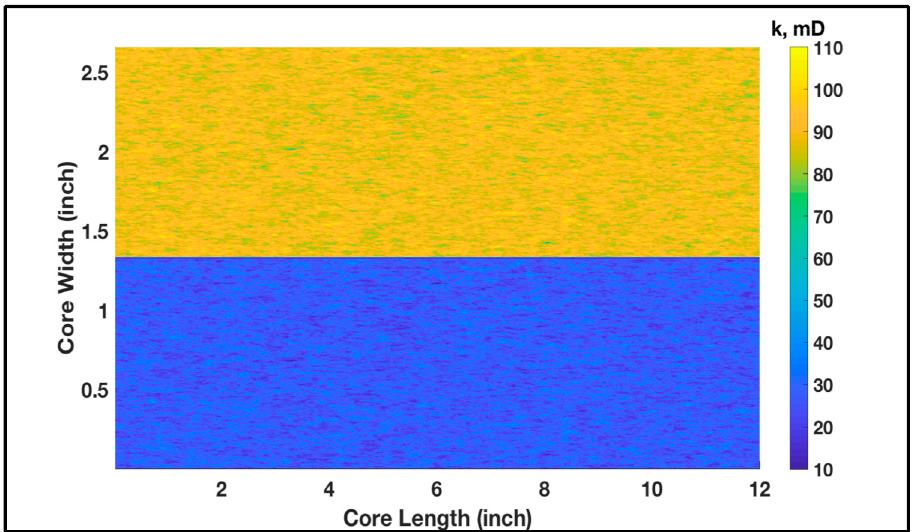
Figure 3. Spatially correlated permeability ( I x = 3.0, I y = 0.8, σ k = 3.0) along the core dimensions before treatment.